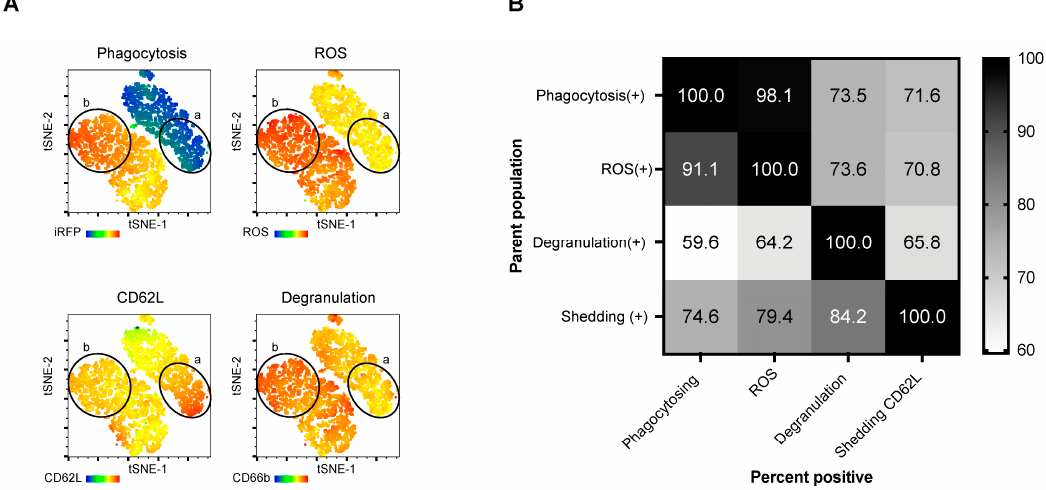
Figure 3. The multiparametric assay allows for the detection of neutrophils performing combinations of simultaneous functions. ( A ) tSNE projection of neutrophils incubated for 30 min with MOI of 4 C. albicans . Heatmap statistics of each flow cytometry parameter were individually overlayed to visualize low functioning (a) and multifunctioning (b) neutrophil subpopulations. ( B ) Neutrophils were co- cultured with C. albicans (MOI of 2) for 30 min. Neutrophil populations can be compared for activity in multiple functions. Above, neutrophils are gated on a single-parent function. Subsequently, we show the frequency of neutrophils from the parent function concurrently exhibiting a second function. Each row represents the positive population of neutrophils for a given parent function. Each column represents the mean percentage of neutrophils from the parent gate undergoing an additional function. n = 3 per experiment per donor; experiments were repeated four times with four different